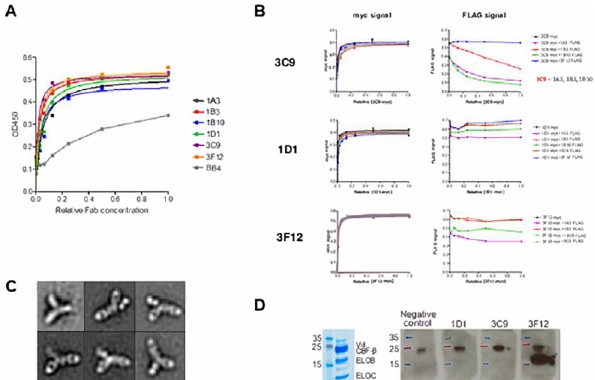
Fig 3. Selection of Fabs against VCBC. A . Qualitative ELISA: Serial dilutions of supernatant of independent clones were added to wells coated with biotinylated VCBC complex. The non-diluted supernatant was considered a relative Fab concentration of 1. The Fab bound to the wells was detected with anti-myc antibody conjugated to horse radish peroxidase. All the Fabs except BB4 displayed saturating signals. B . Competitive ELISA: The binding of serial dilutions of 3C9-myc, 1D1-myc and 3F12-myc Fabs supernatants were measured in the presence of saturating constant concentrations of Fab-FLAG. The Fab bound to the wells was detected with anti-myc (left panel) or anti-FLAG (right panel) antibodies. C . Representative negative stain 2D class averages of VCBC in complex with the three selected Fabs (3C9, 1D1 and 3F12). D . Detection of VCBC by western blot using 3C9-myc, 1D1-myc and 3F12-myc as primary antibodies and anti-myc-HRP as secondary antibody. Only 3F12 binds to the denatured form of VCBC and recognizes a linear epitope in ELOB. One blot without primary antibody was used as negative control.